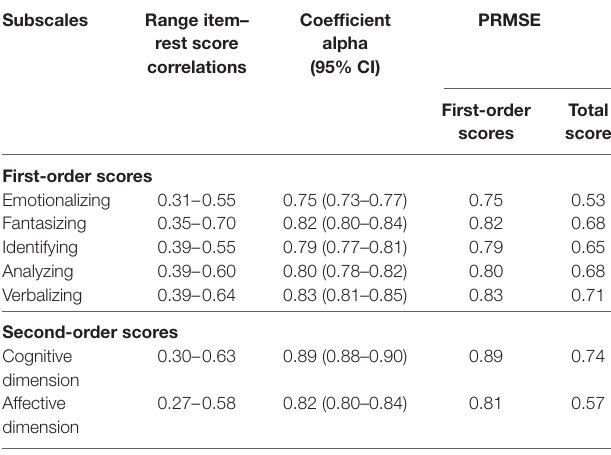
TaBle 4 | Reliability and additional values (PRMSEs) of the first-order and second-order scores of the BVAQ (results obtained in the total sample). subscales range item– rest score